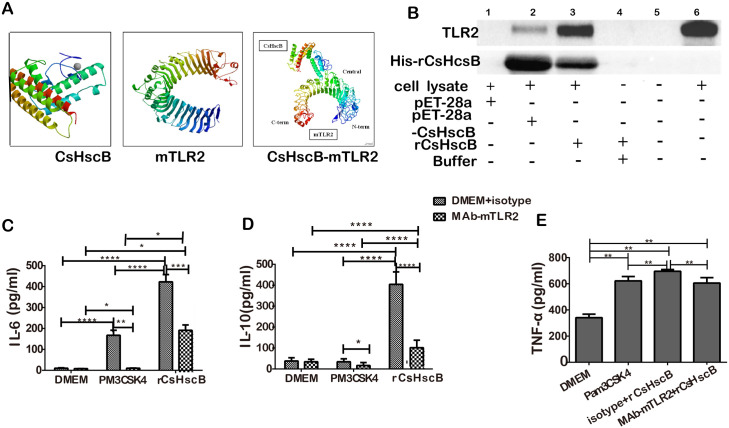
rCsHscB is a novel agonist for TLR2 to induce immune responses of macrophage.(A) Molecular docking analysis of binding TLR2 with CsHscB. (B) Pull-down assay analysis of the interaction of TLR2 and rCsHscB. The cells stimulated by supernatant of lysate from E. Coli transfecting with Vector controls (pET-28, His-tagged control, Lane 1), pET-28a-CsHscB vectors (pET-28-CsHscB, unpurified, Lane 2), purified rCsHscB-stimulated cells (Lane 3), binding buffer (Lane 4) and medium (Lane 6) for 24 h, the cells (from line 1~ line 5) were lysed and incubated with rCsHscB immobilized on Ni-NTA beads; bead-bound proteins (from line 1~ line 5) and cell lysates (line 6 without rCsHscB immobilized on Ni-NTA beads) were loaded onto a gel for immunoblotting for both TLR2 and rCsHscB. Lane 5 represents negative control for pull-down assay; line 6 represents positive control for TLR2. (C~E) The production of IL-6 (C), IL-10 (D), and TNF-α (E) were hindered in rCsHscB-stimulated cells when TLR2 was blocked by a neutralizing antibody of TLR2. PM3CSK4 was used as TLR2 ligand for positive controls. Quantitative data are representative of mean ± SEM of at least three independent experiments (n = 4).*P < 0.05, **P< 0.01, and ***P< 0.001 compared with indicated group.